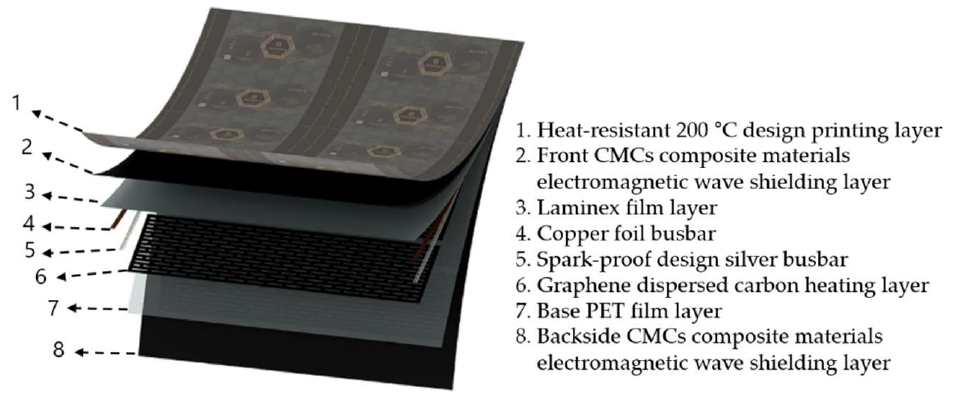
A single des-HF film was composed of eight different functional individual thin films, as shown in Figure 11.